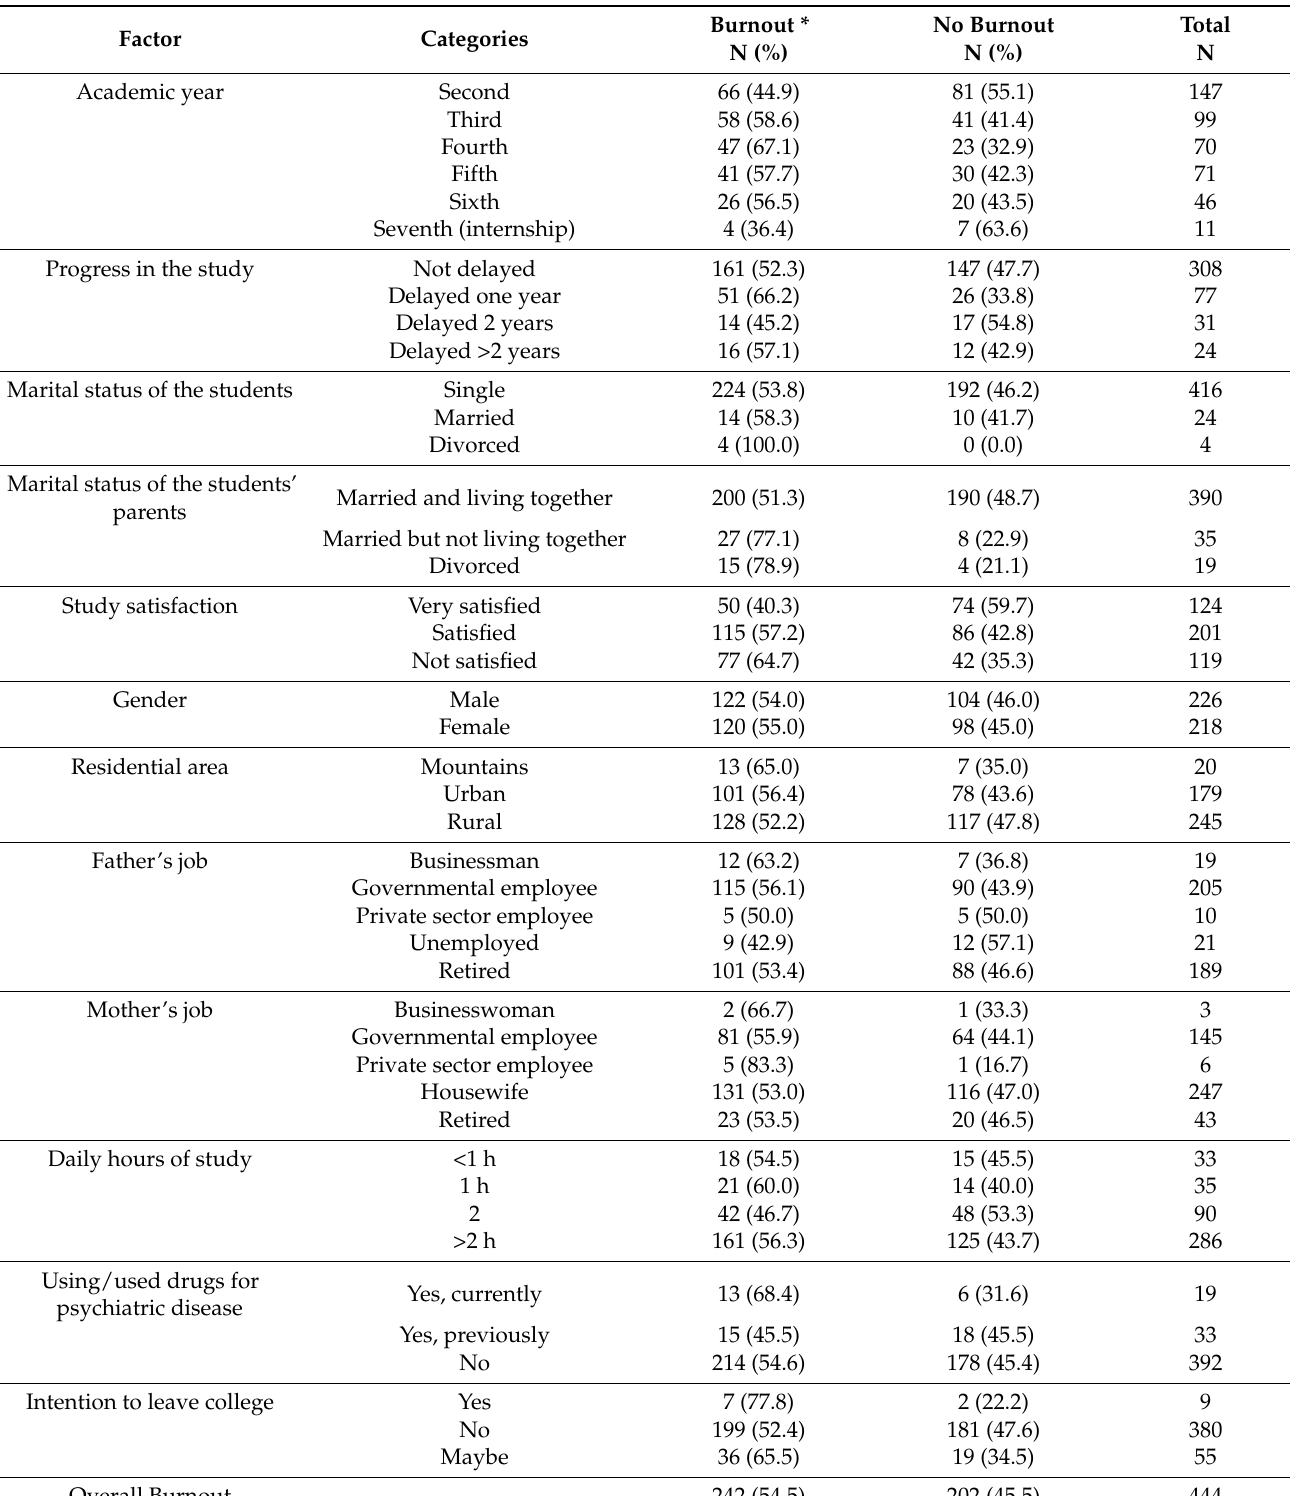
Table 1. Categorization of burnout according to selected students’